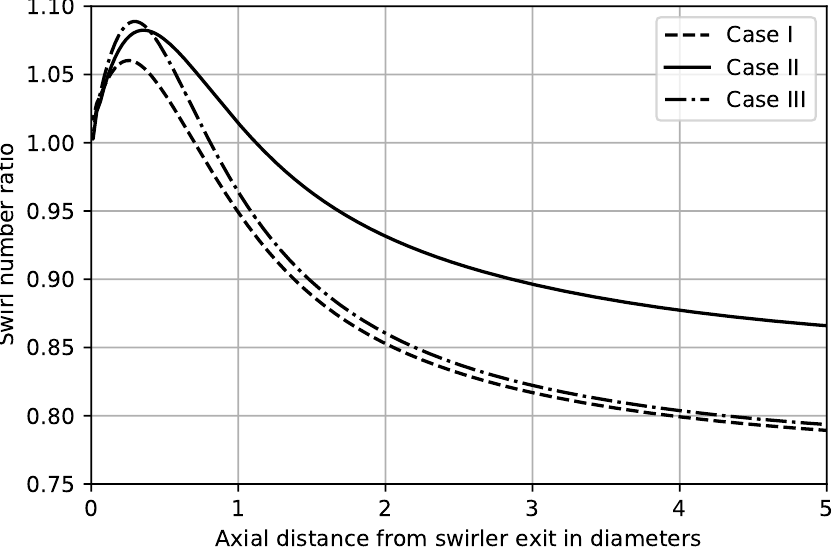
Figure 14. Swirling number decay, expressed as a ratio compared to a theoretical decay, for Cases